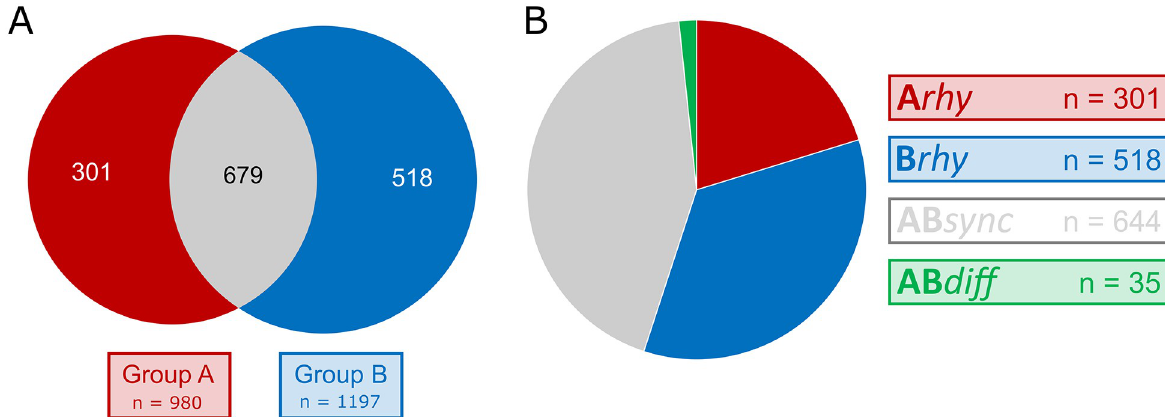
Fig 4. Distribution of rhythmically expressed genes in the E19 fetal rat SCN. (A) Transcripts identified as rhythmic by dryR analysis in either Group A (red), Group B (blue), or both groups (gray). (B) Transcripts assigned to their respective subsets: rhythmic in Group A ( Arhy , red), rhythmic in Group B ( Brhy , blue), and transcripts rhythmic in both groups with similar ( ABsync , gray) or different circadian parameters ( ABdiff , green). SCN, suprachiasmatic nuclei.